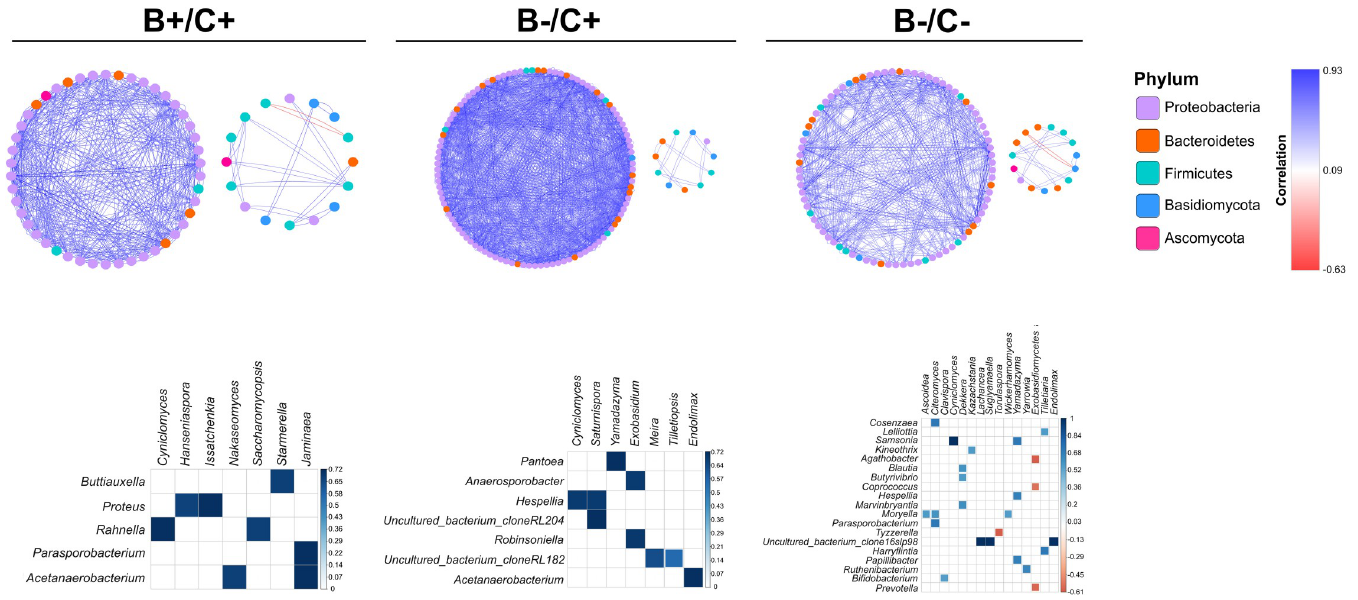
Fig 4. Intra-domain and inter-domain correlations in the three study groups. Correlation networks of the B+/C+ (top left), B-/C+ (top center), and B-/C- (top right) groups. The nodes represent the bacterial and eukaryotic families, and its color represents the phylum to which it belongs. Blue edges and red edges indicate positive and negative correlations, respectively. The networks only represent significant correlations (p < 0.05, after FDR correction) with ρ above 0.6 and lower than -0.6, and that were computed with the Spearman correlation test. This figure also displays correlation plots of the genera belonging to the most abundant bacterial and eukaryotic families of the B+/C+ (bottom left), B-/C+ (bottom center), and B-/C- (bottom right) groups. Blue and red squares represent positive and negative correlations, respectively. Only significant correlations, computed with the Spearman correlation test, (p < 0.05, after FDR correction) were represented in the mentioned plots.